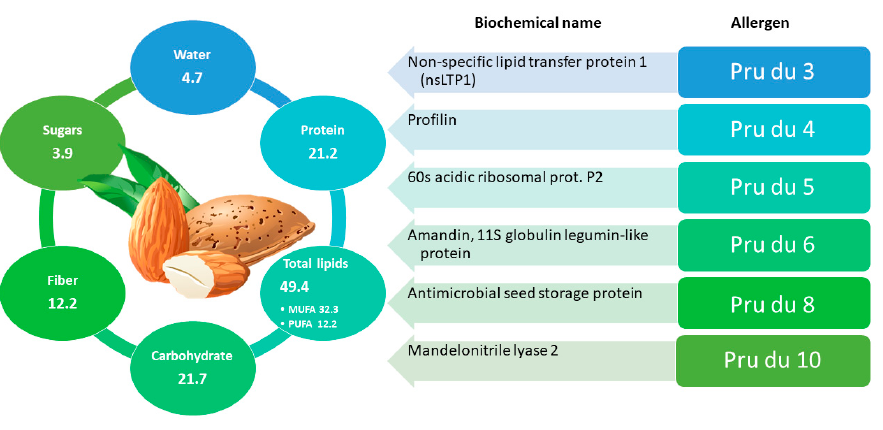
Figure 2. ( Left ) Relevant information on the nutritional composition (g/100 g) relating to the Prunus dulcis species. ( Right ) list of allergenic proteins identified and registered to date for Prunus dulcis on the WHO/IUIS online allergen nomenclature platform.